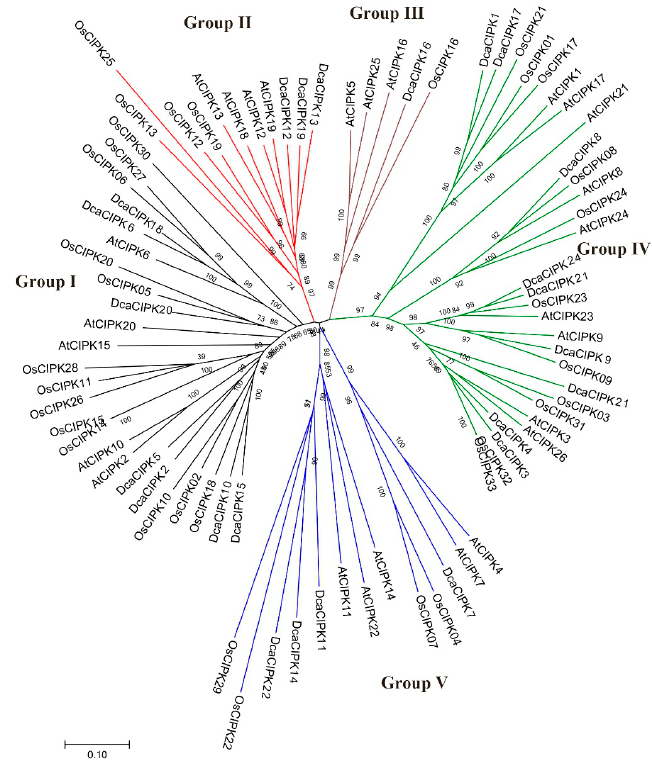
Figure 3. Evolutionary analysis of Dca CIPK proteins. Full-length sequences of 83 CIPK proteins from D. catenatum , Arabidopsis, and rice were used to construct the phylogenetic tree using MEGA7 with the NJ method. Subfamilies (I–V) are highlighted with different colors.